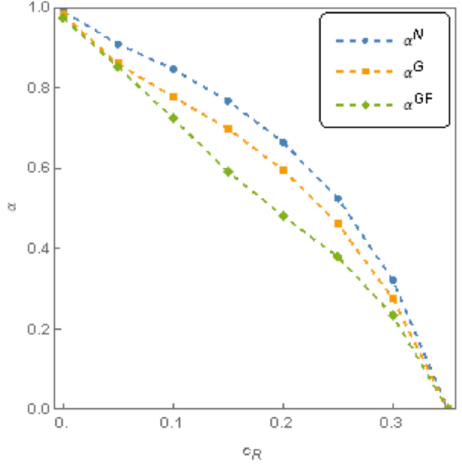
Figure 3. Outsourcing ratio analysis for different development models.